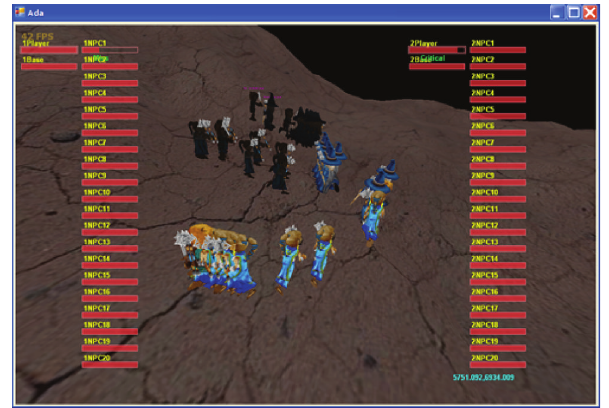
Figure 10: A screenshot of the SAP hierarchical learning framework experimental game environment. The game represents a typical real-time strategy (RTS) game setting. Team A consists of the lighter-colored characters (mainly on the bottom portion of the figure) whilst Team B consists of the dark-colored characters (mainly on the top portion of the